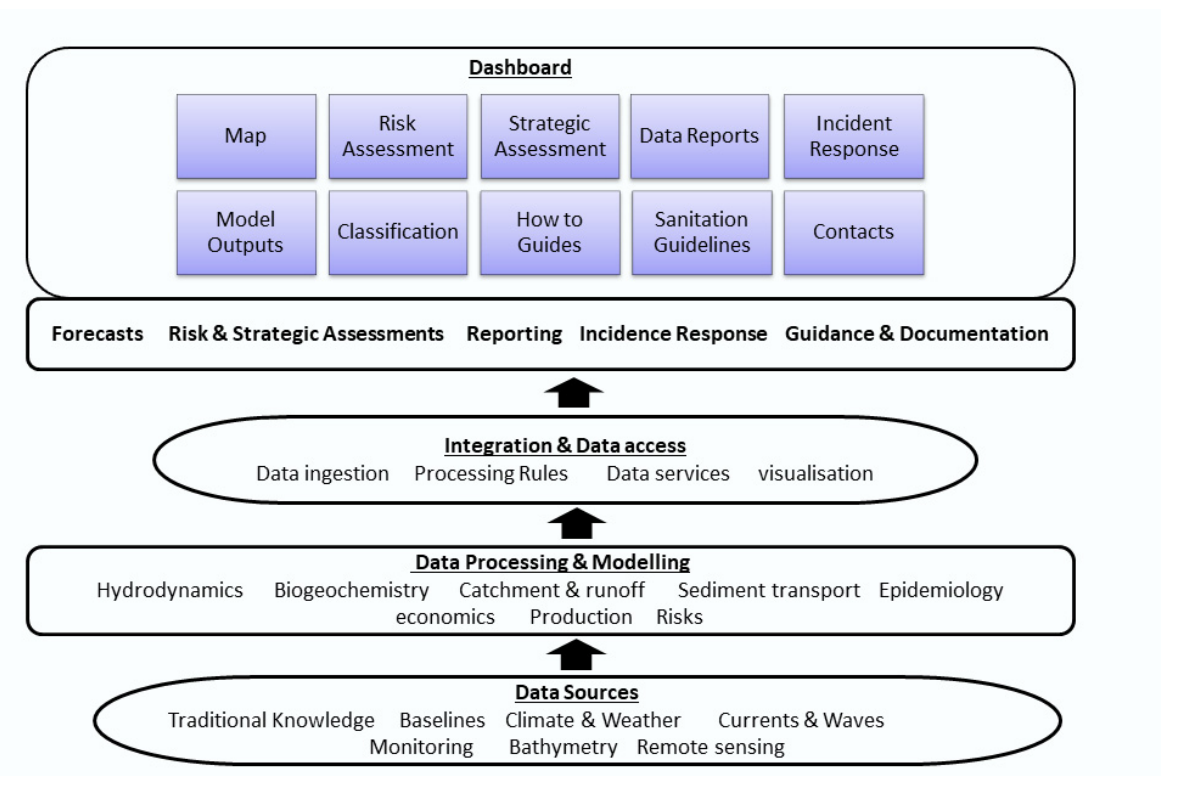
Figure 1. Conceptual diagram of SIMA (Spanish for Integrated Management System for Aquaculture) information platform showing user-level functionality and the SIMA models and databases to be implemented (adapted from Figure 1 in [30], see Section 2.2.2 for details).